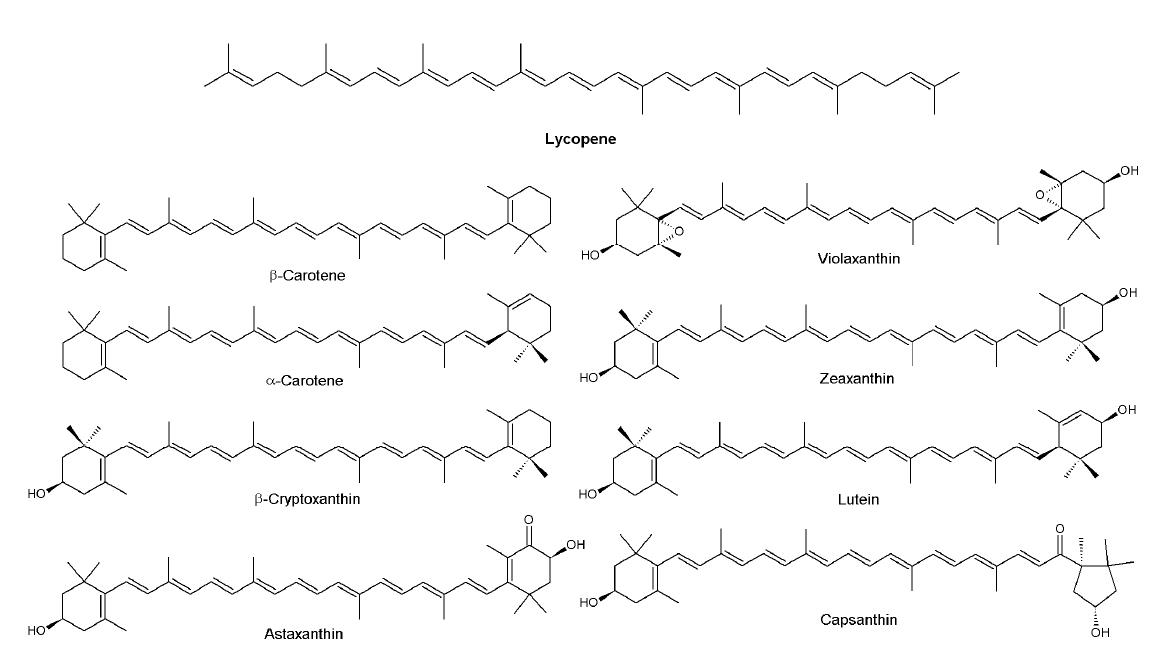
Figure 7. Chemical structure of lycopene with the main primary and secondary carotenoids.